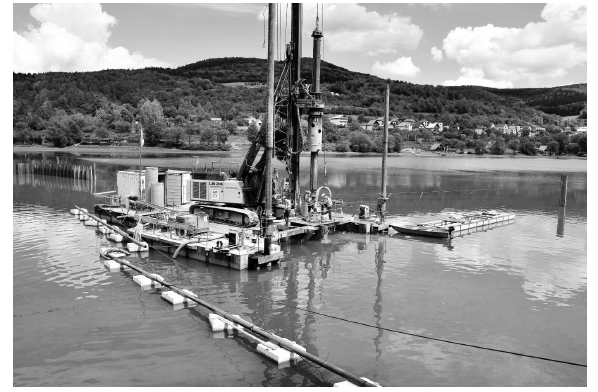
Figure 2. Realization of piles from pontoon